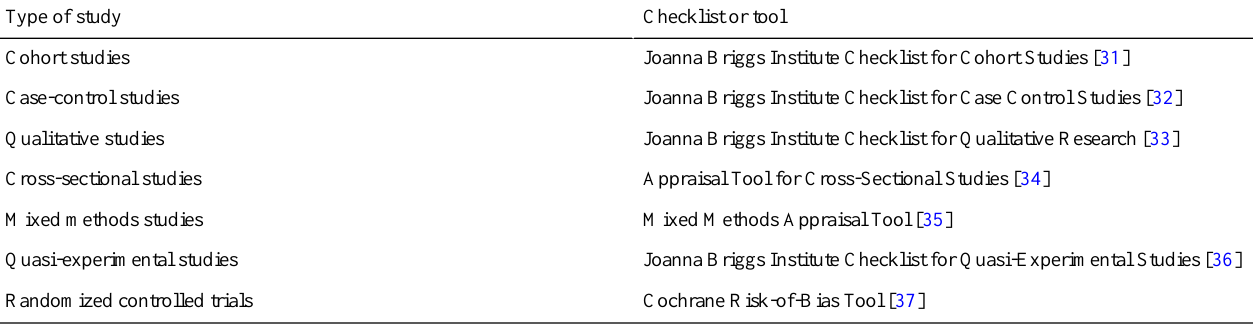
Table 2. Checklist for the assessment of methodological quality.